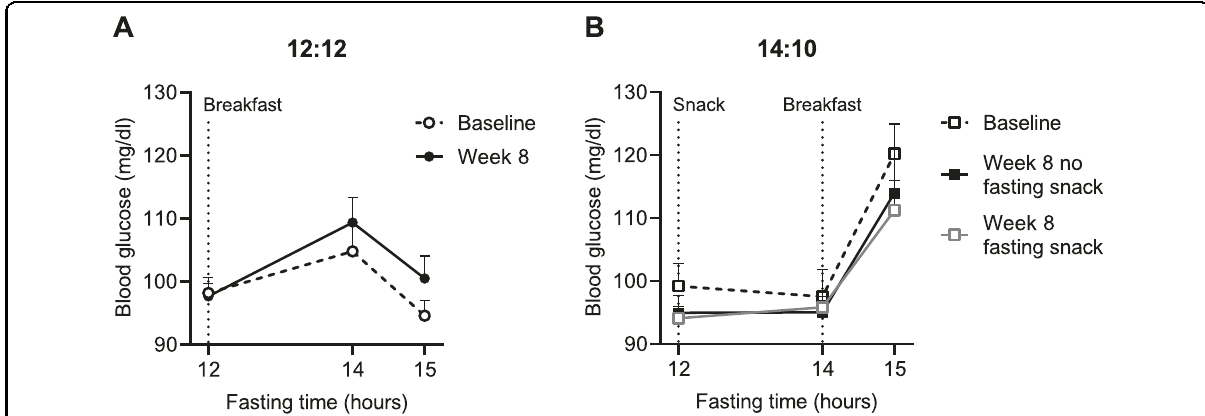
Fig. 4 Effect of the fasting snack on blood glucose in study completers. A Change in blood glucose after a breakfast meal for 12:12 study completers ( n = 30). Participants ate breakfast after the 12-hour FBG measurement. B Blood glucose response to a fasting snack and breakfast meal for 14:10 study completers at baseline (no fasting snack) and Week 8 (no fasting snack) ( n = 30). Participants ate the fasting snack after the 12-h blood glucose measurement and ate breakfast after the 14-h blood glucose measurement. Data are mean ±